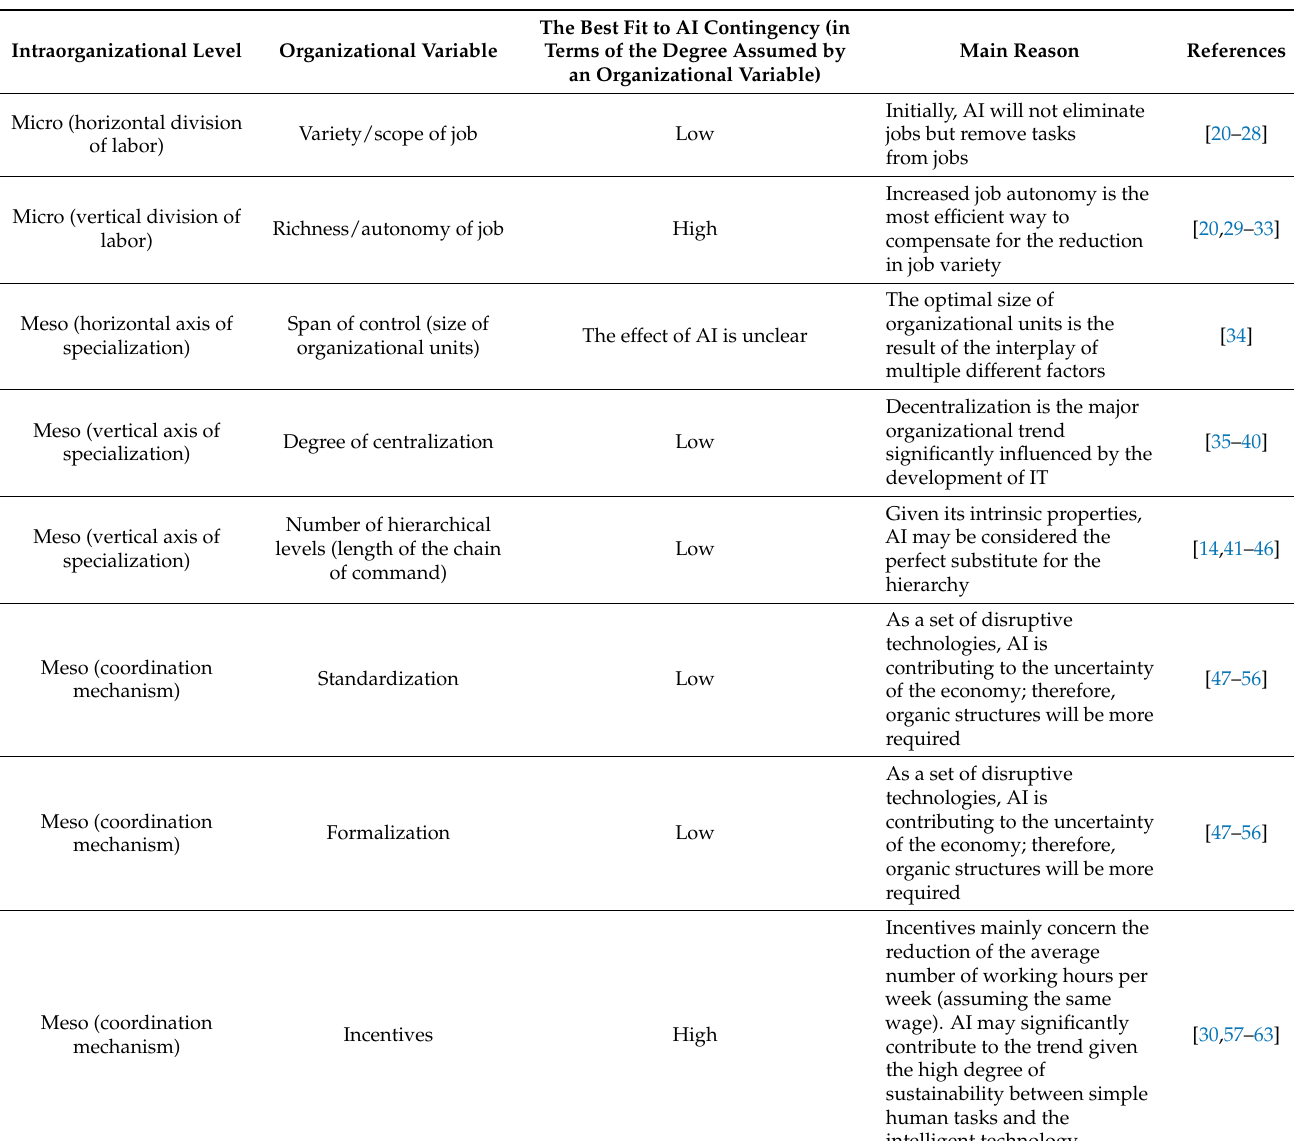
Table 1. Hypothesized best fits to the AI